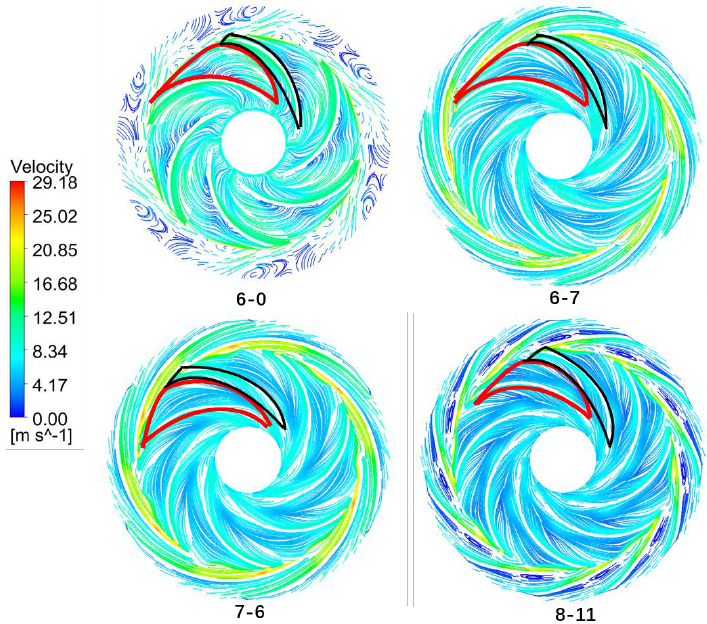
Figure 11. Velocity streamline of high-speed pump under four computational cases.